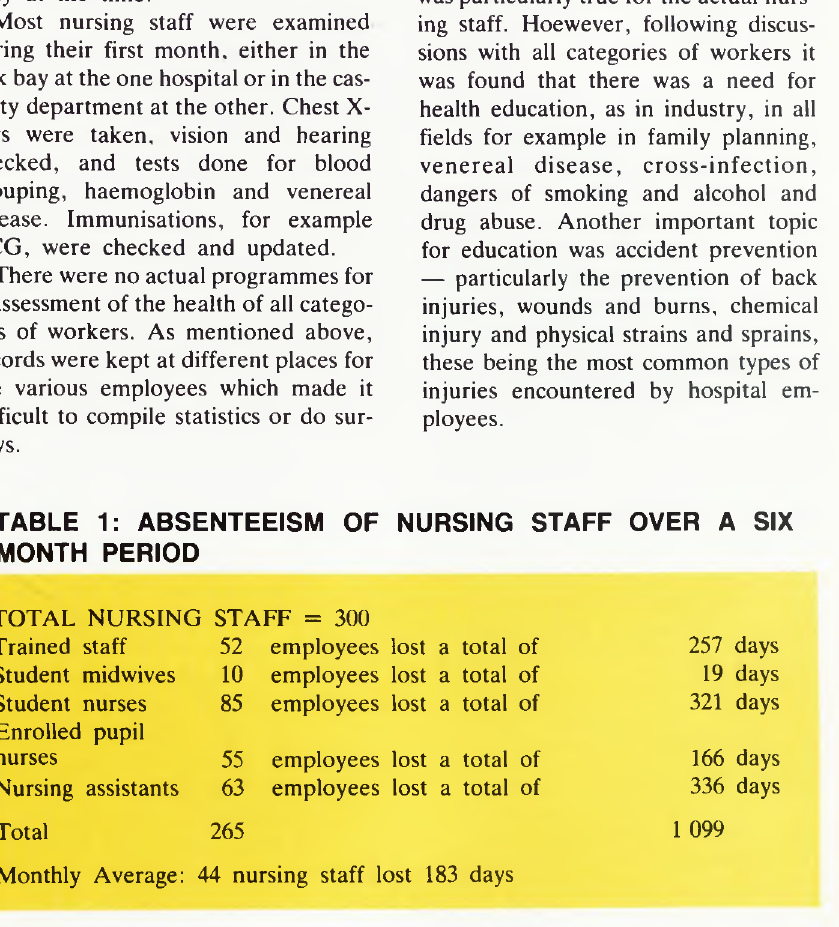
TABLE 1: ABSENTEEISM OF NURSING STAFF OVER A